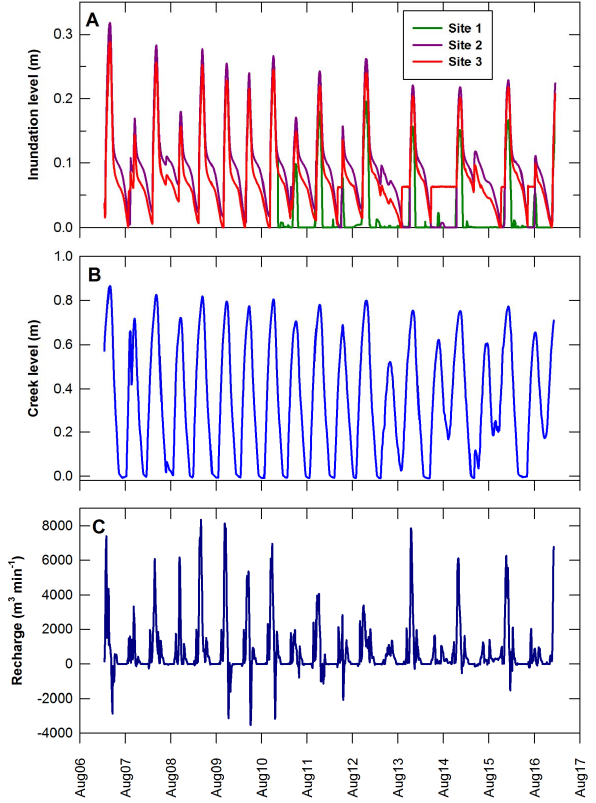
Fig. 4. Water levels inundating the mangrove forest at three measurement locations (Fig. 2) along a transect ( A ) and within the mouth of the tidal creek ( B ). Recharge at the mouth of the tidal creek ( C ) showing flow into the forest (recharge>0) during flood tide and drainage (recharge<0) into Shark River during ebb tides.